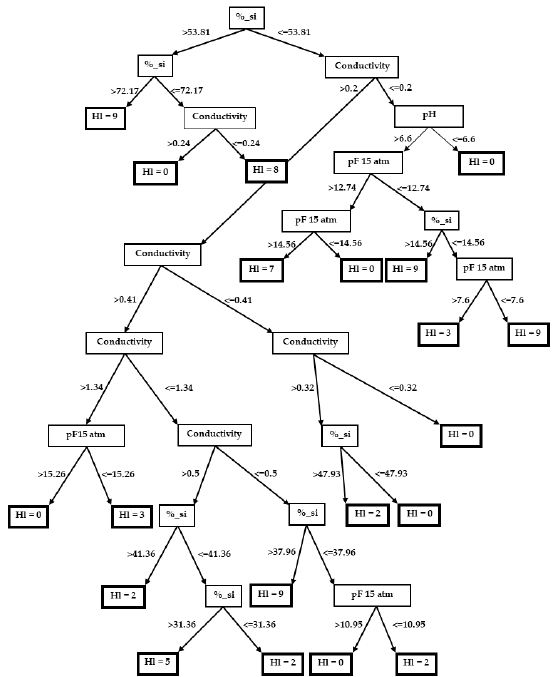
Figure 5. Decision tree for Hl = Hordeum leporinum . The numbering inside the boxes represents the abundance–dominance index converted to Van der Maarel [40]. The other numbering corresponds to the range of values of the edaphic attributes.